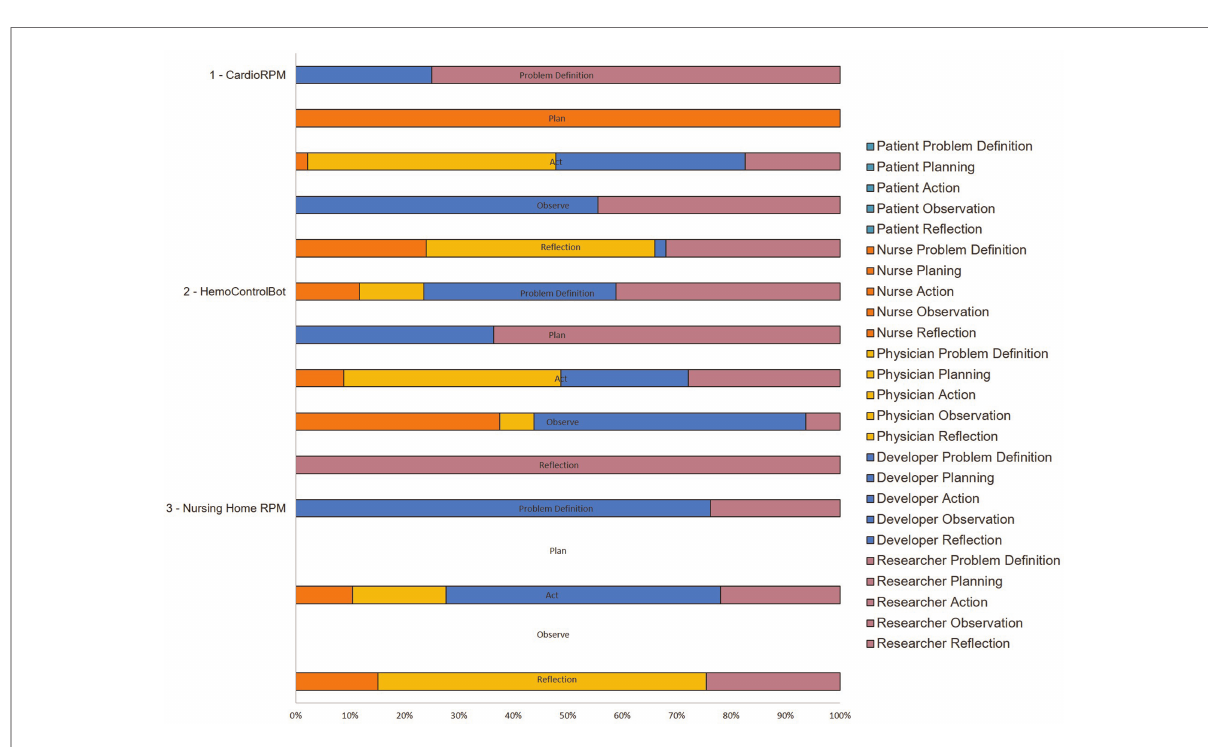
FIGURE 2 Level of participation of each team role per PAR phase per pilot